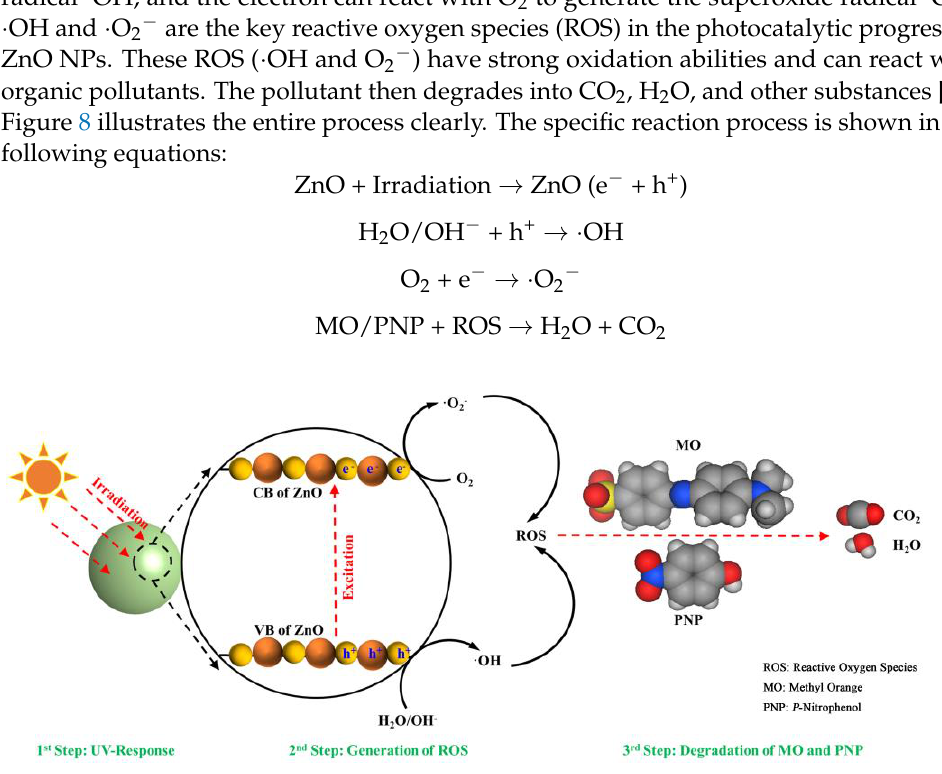
Figure 8. Photocatalytic mechanism of ZnO NPs.